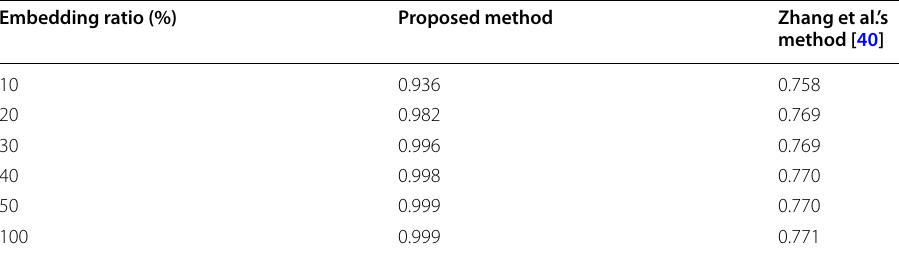
Table 7 Comparison of the accuracy of methods for the BOWS2 image database Embedding ratio (%)